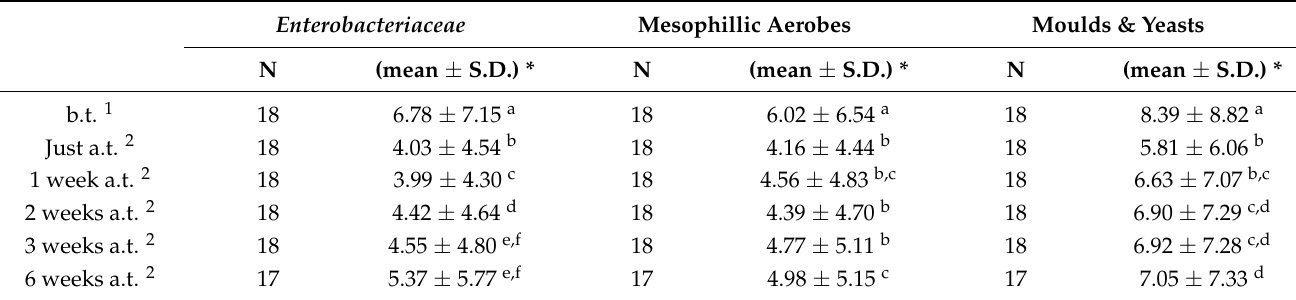
Table 4. Evaluation of the microbial load, at six different times, in bee-pollen treated mixing 30 min ozone exposure together with 15 min hot-air drying and kept in a refrigerator at 4 ◦ C. The results are expressed as number of samples (N) and average of CFU counted (mean ± S.D.).